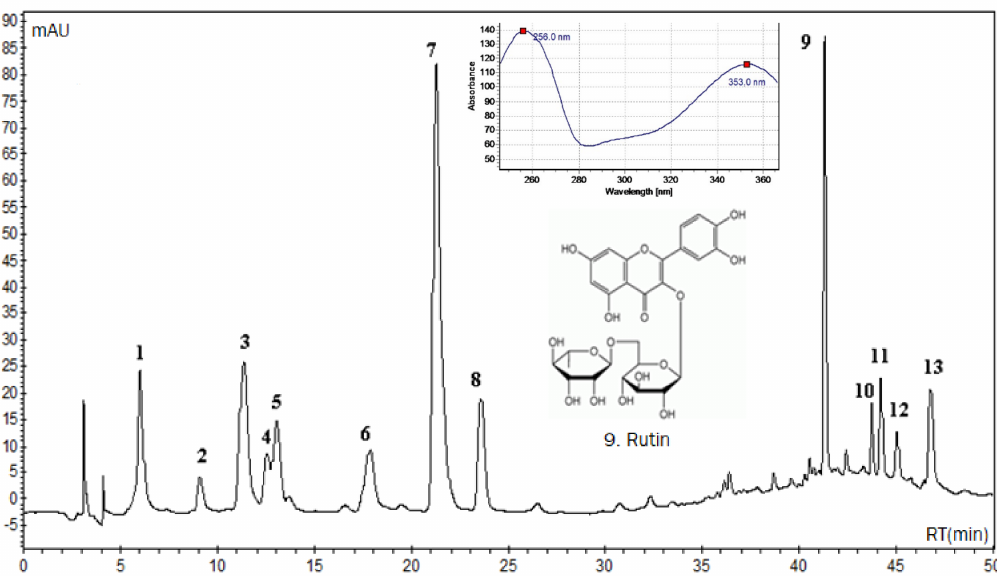
Figure 1. High Performance Liquid Chromatography coupled with Diode Array Detector (HPLC-DAD) chromatogram of aqueous extract from the leaves of Aspidosperma pyrifolium (3 mg/mL). The analysis shows one peak (retention time: 41.18 min) corresponding to rutin (inset shows structure and maximum UV absorption at 256 nm and 353 nm). The separation was performed using a Reverse Phase Luna C-18 column (4.6 mm × 250 mm, 5 µ m; Phenomenex). The solvent system used was a gradient of 0.3% acetic acid in water: acetonitrile with a flow rate kept at 1.0 mL min − 1 . Detection at 340